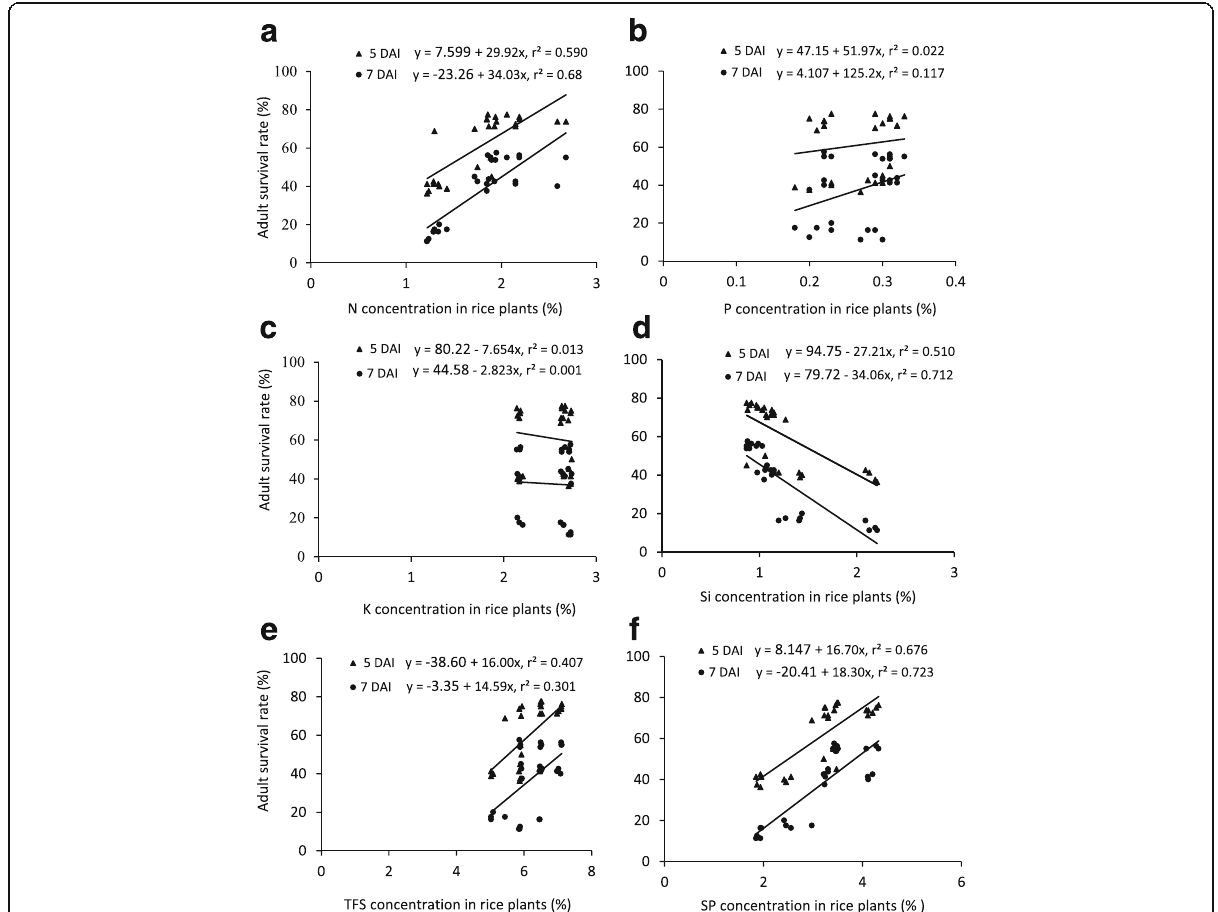
Fig. 3 Relationship of Nilaparvata lugens adult survival rate at 5 days after infestation (DAI) and 7 DAI with plant tissue nutrient concentration. a nitrogen (N), b phosphorus (P), c potassium (K), d silicon (Si), e total free sugar (TFS), and f soluble protein content in rice plant ( n =